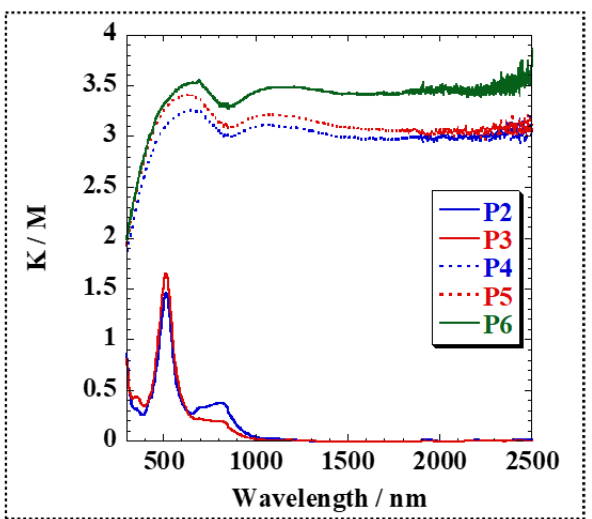
Figure 2. UV-Vis-NIR spectra of polymers ( P2 - P5 ) dissolved in phosphate buffer. [polymer] = 4.0 g/L, cell length: 0.1 mm.